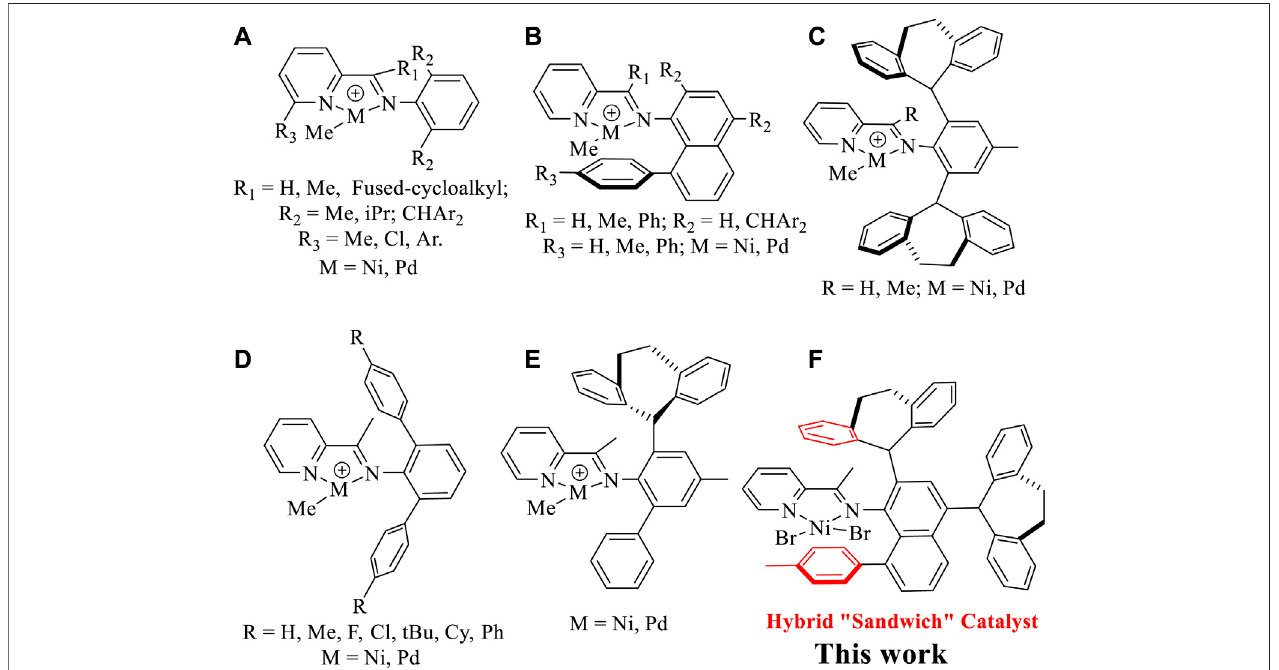
CHART 1 | Modi fi cations of pyridine-imine Ni(II) and Pd(II) catalysts (A – E) , and our current work (F) .